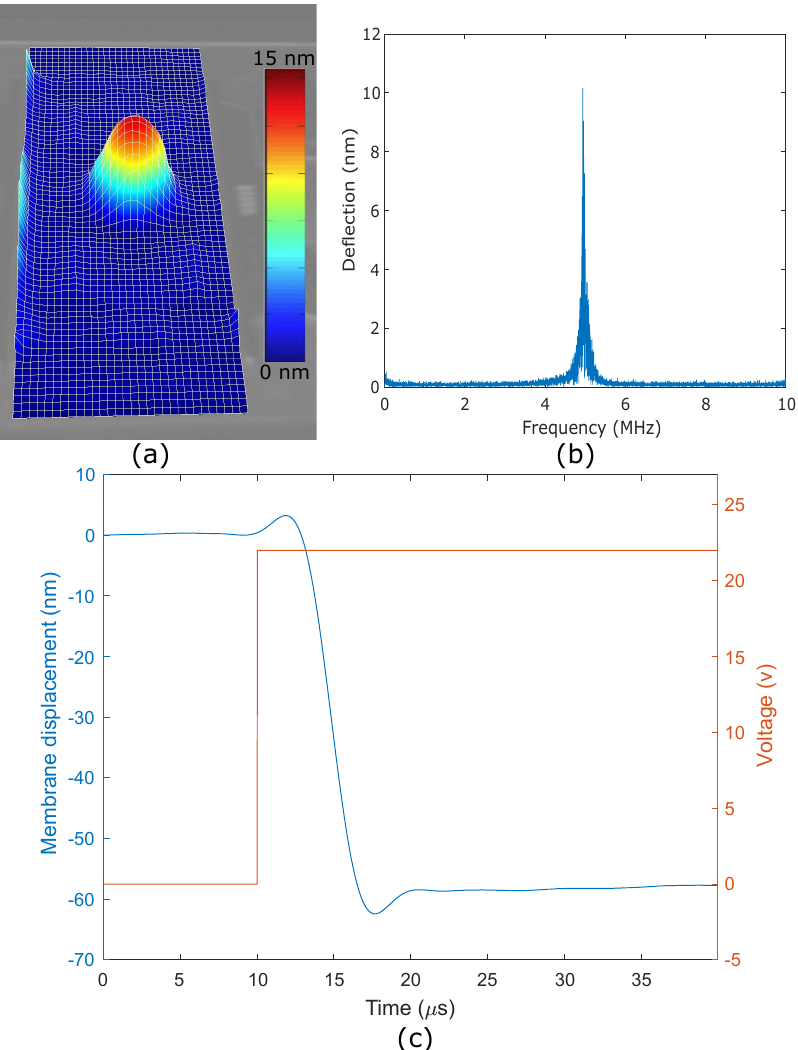
Figure 11. Sample laser Doppler vibrometry measurements. ( a ) The 2D scan showing the membrane displacement for a given frequency. ( b ) Single-point measurement using an 8 V AC signal. The peak shows the first fundamental frequency of the membrane. ( c ) Single-point time domain measurement of the membrane displacement for a step function input with a 22 V